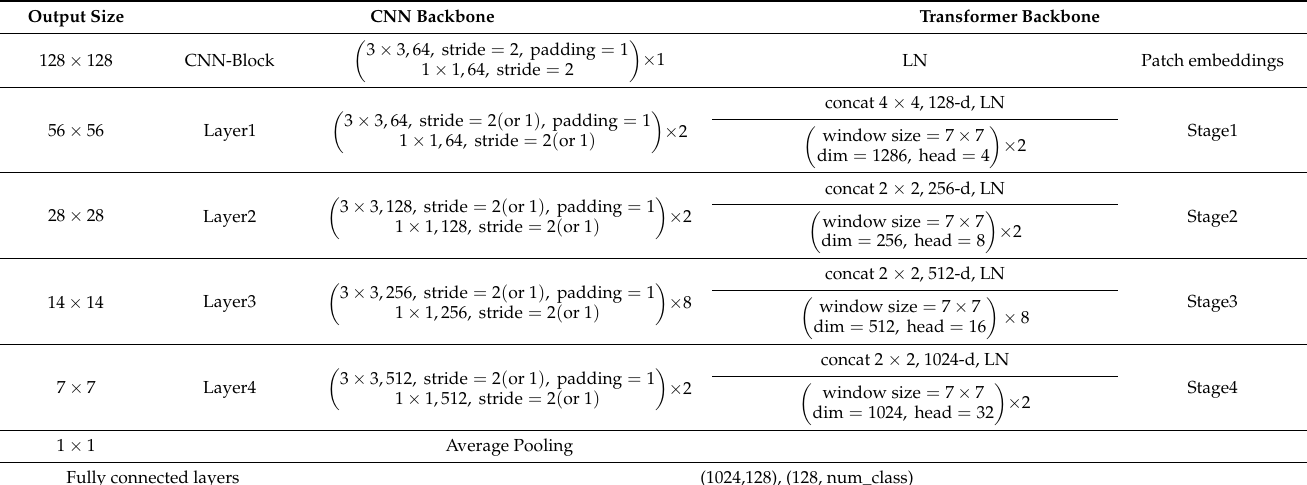
Table 2. Architectural details of